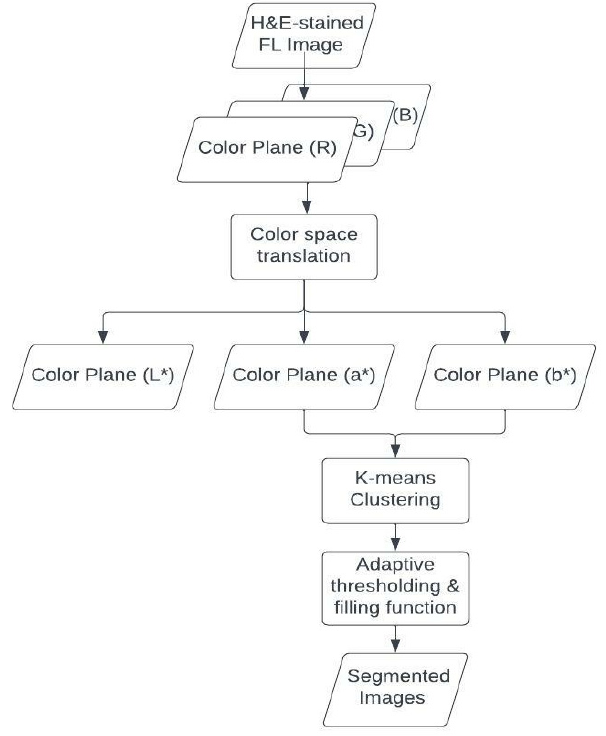
Figure 4. Process flow to isolate different cytological components from H&E-Stained image.